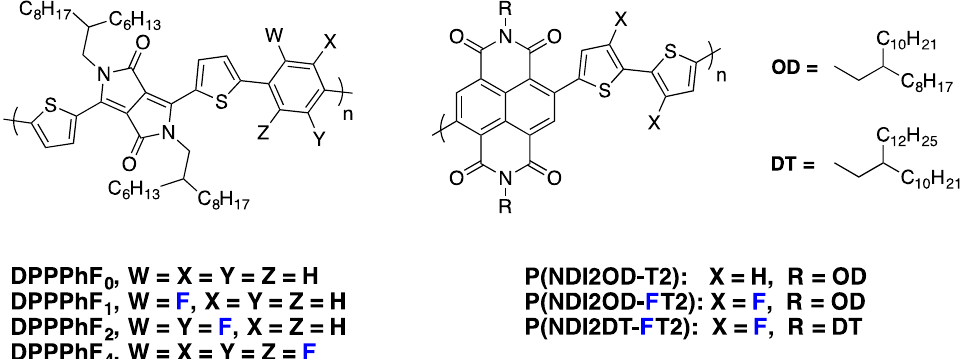
Figure 21. Chemical structures of n- type fluorinated copolymers.